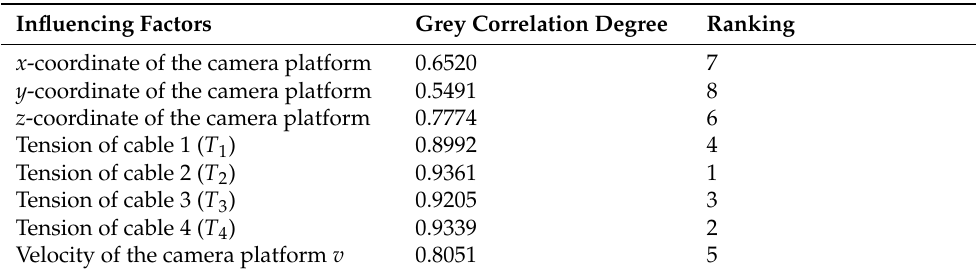
Table 4. Grey correlation degree of the eight influencing factors on the dynamic stability.